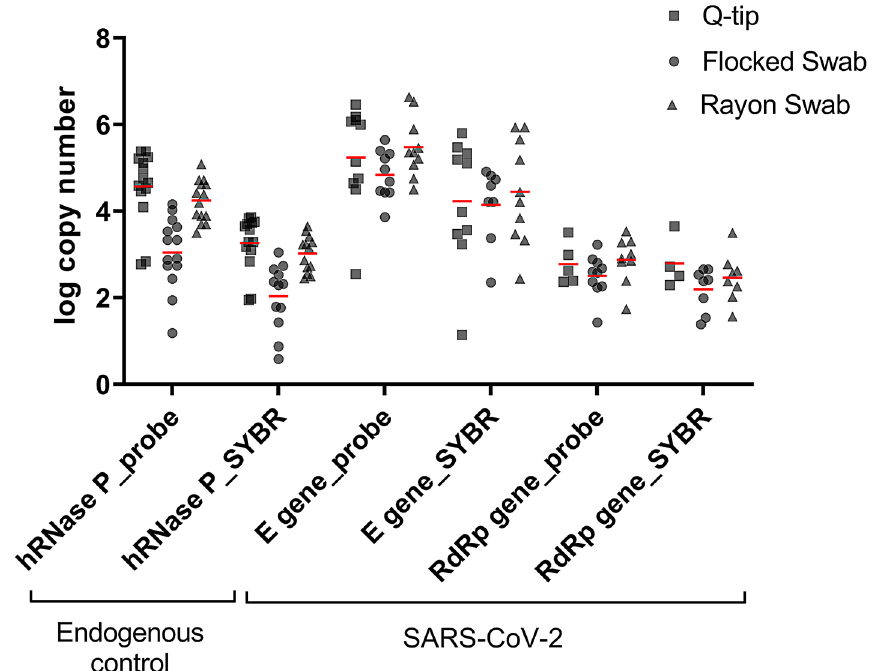
Figure 3. Comparison of the performance of the SYBR RT-qPCR and hydrolysis-probe based RT-qPCR methods in detecting the target genes in different swab types of SARS-CoV-2 infected participants (n = 7). RNA was extracted with the classical protocol or the commercial kit. Means are represented by red